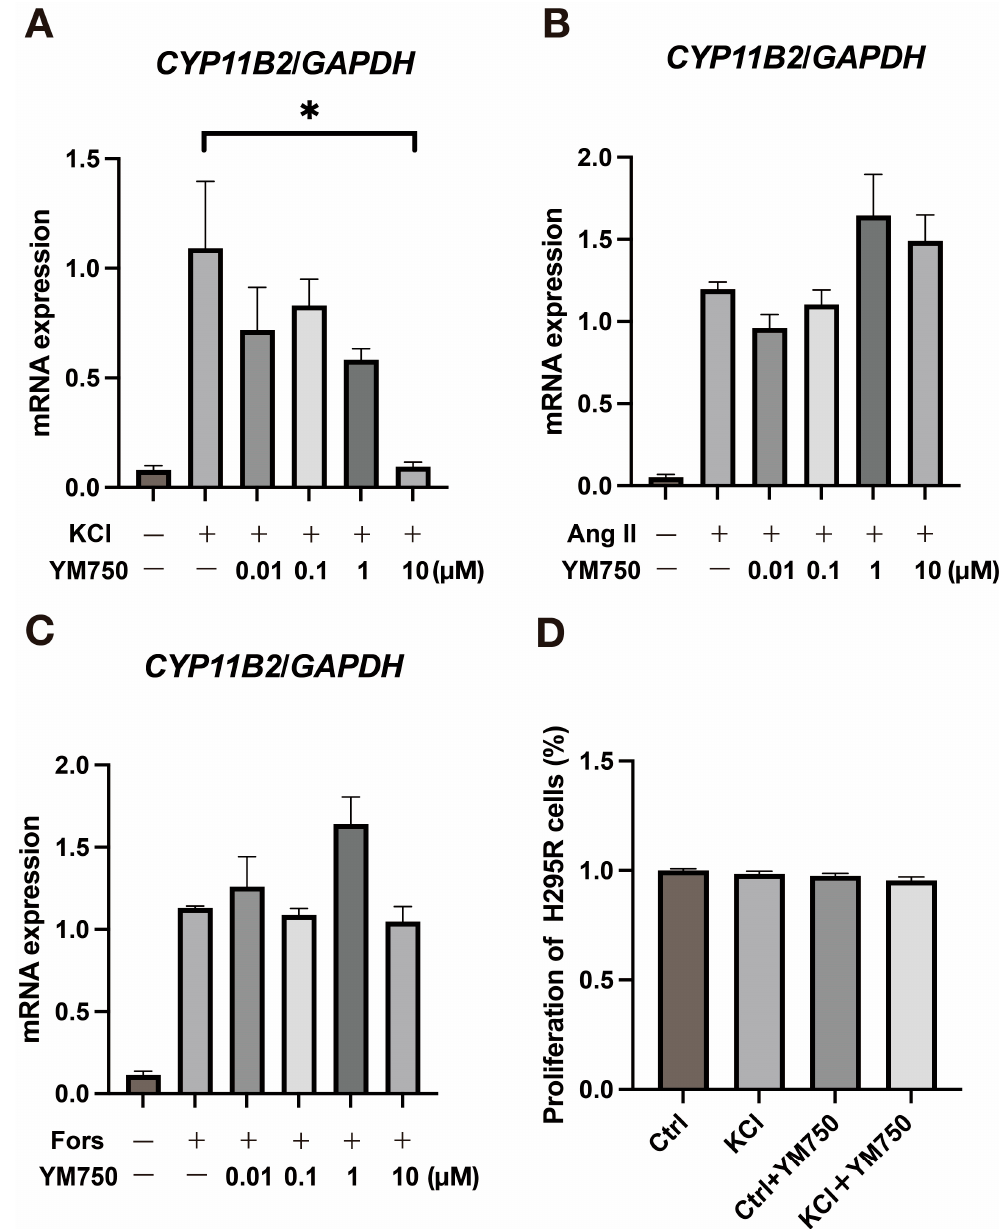
Figure 1. Effect of YM750 on CYP11B2 expression induced by various stimuli. ( A ) Effect of YM750 on CYP11B2 expression induced by KCl (20 mM) stimulation. ( B ) Effect of YM750 on CYP11B2 expression induced by angiotensin II (100 nM) stimulation. ( C ) Effect of YM750 on CYP11B2 expression induced by forskolin (10 µM) stimulation. ( D ) Effect of YM750 (10 µM) on H295R cell proliferation. * p < 0.05, n = 3.